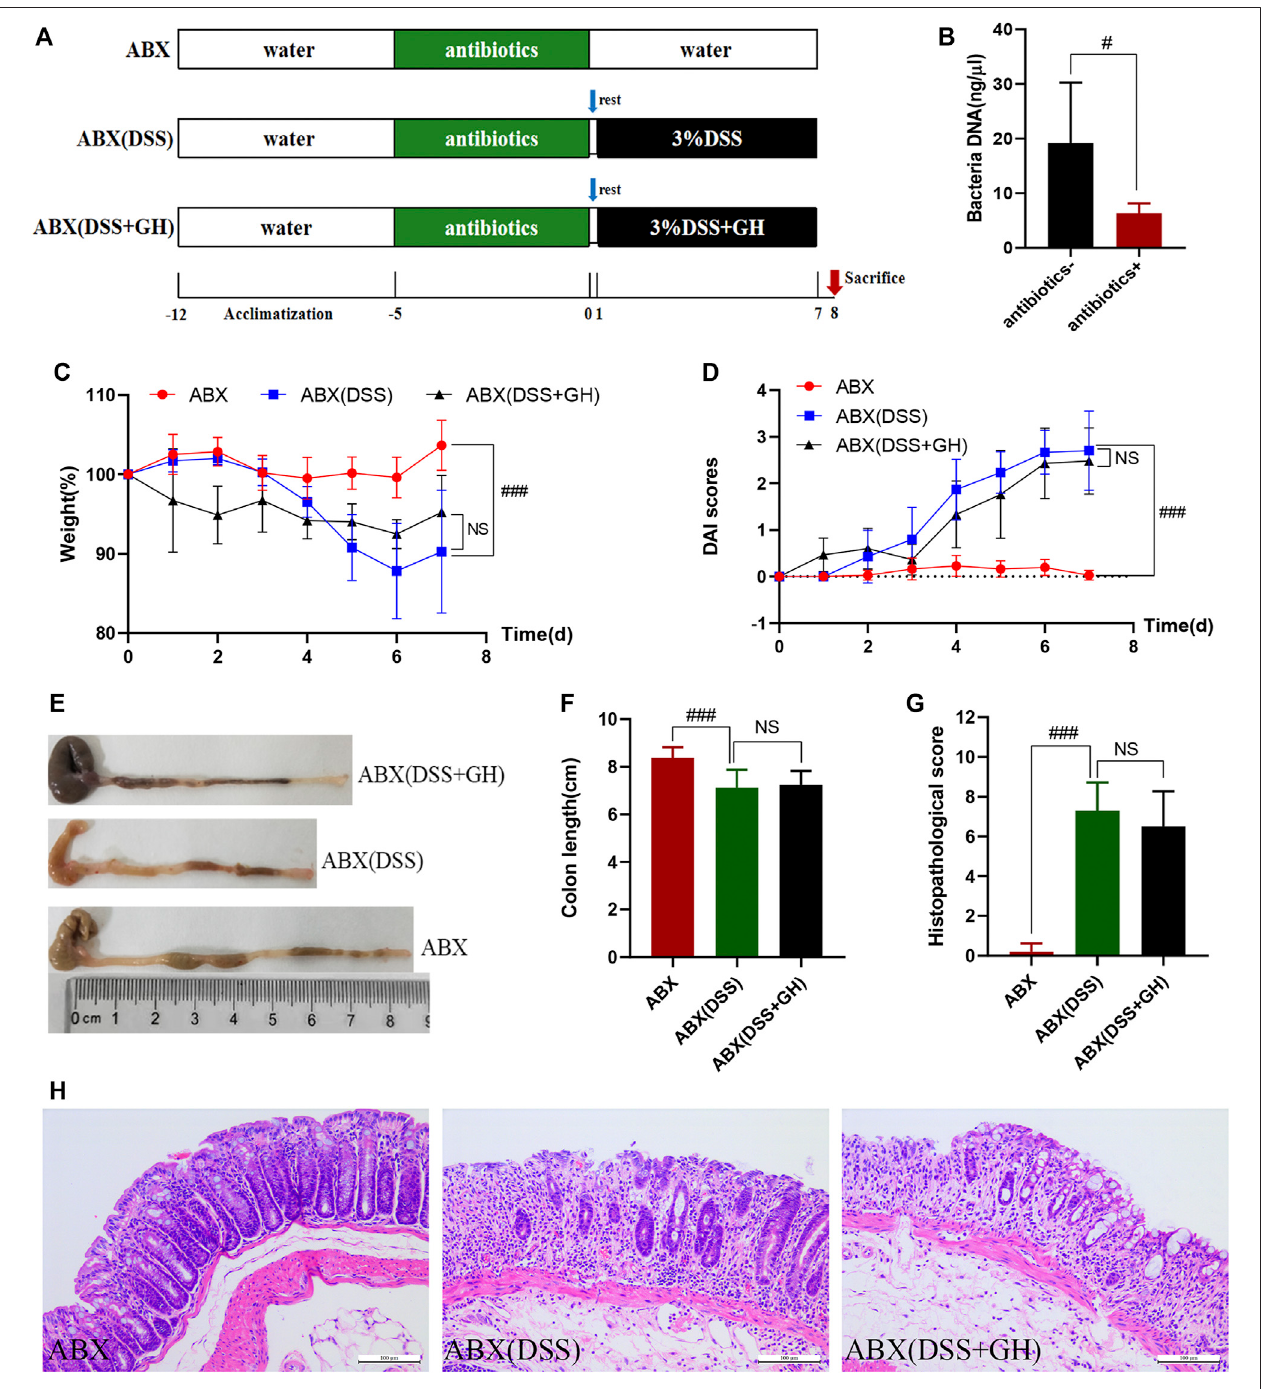
FIGURE 2 | MGQD attenuated DSS-induced colonic in fl ammation in a gut microbiota dependent manner. (A) Experimental timeline. (B) Total DNA concentration from the gut microbiota in mice fecal samples. (C) Body weight change. (D) DAI score. (E) Representative photograph of colons. (F) Statistics of colon length. (G) The histologicalscoresofmousecolonmorphology. (H) HistologicalchangesofthecolonbasedonHEstaining(magni fi cation, × 200).Datawereexpressedasmean ± SD(n (cid:2) 10). # p < 0.05, ### p < 0.001 vs ABX group, NS means no statistical signi fi cance. ABX: a gut microbiota depletion group; ABX (DSS): an antibiotic-disposed UC model group; ABX (DSS + GH): an antibiotic-disposed UC model treatment group.